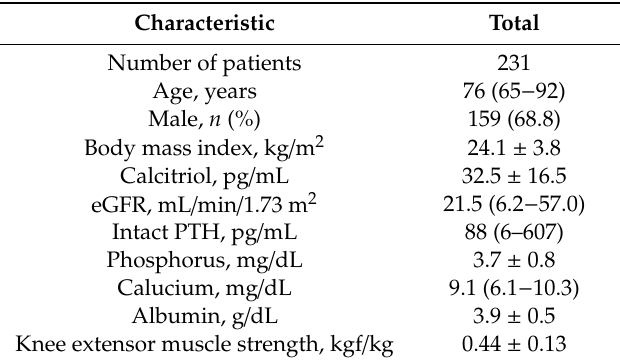
Table 1. Clinical characteristics of the patients.